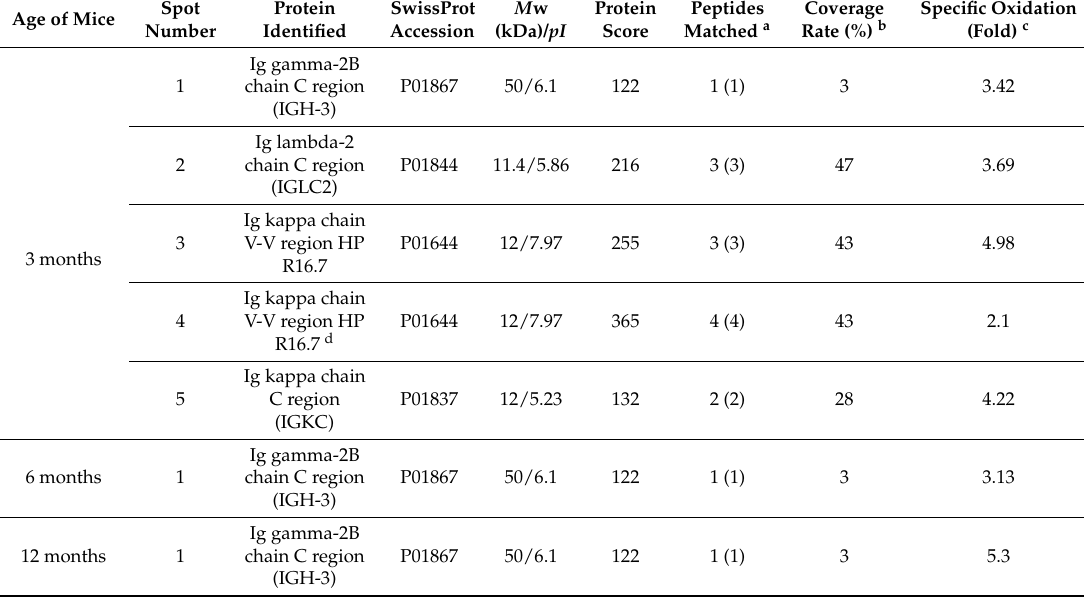
Figure 5. Silver-stained gels and 2D-oxyblots of the serum extracts from 12-month-old controls to 3×Tg-AD mice. Representative 2D gel images of the serum proteomes of control ( A ); and 3×Tg-AD mice ( B ); ( C , D ) are the oxyblots of serums from the control to 3×Tg-AD mice, respectively. Spots that showed a significant difference in specific carbonylation levels are marked with the corresponding protein identity. Table 1. Proteomic identification of oxidatively-modified serum proteins at three months, six months, and 12 months of age from 3 ˆ Tg-AD mice compared with the aged-matched